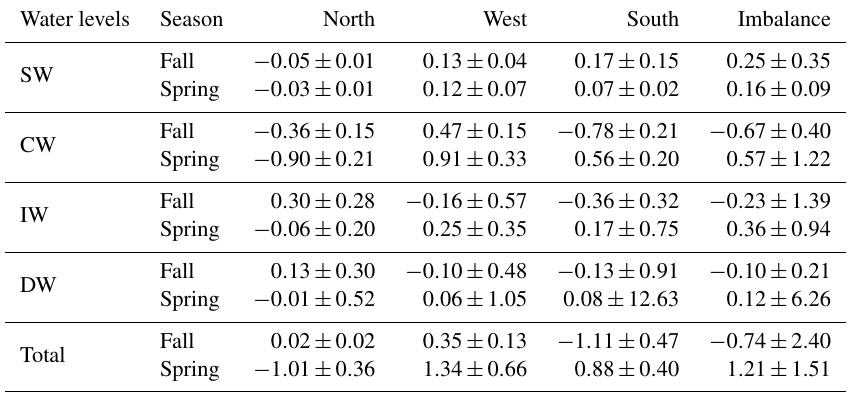
Table 6. NO 3 transports and their errors (kmols − 1 ) for CW, IW and DW for the north, west and south transects. Positive–negative values indicate outward–inward transports. The last row is the integrated transport in the entire water column in each transect, and the last column represents the net transport of this variable inside the box.